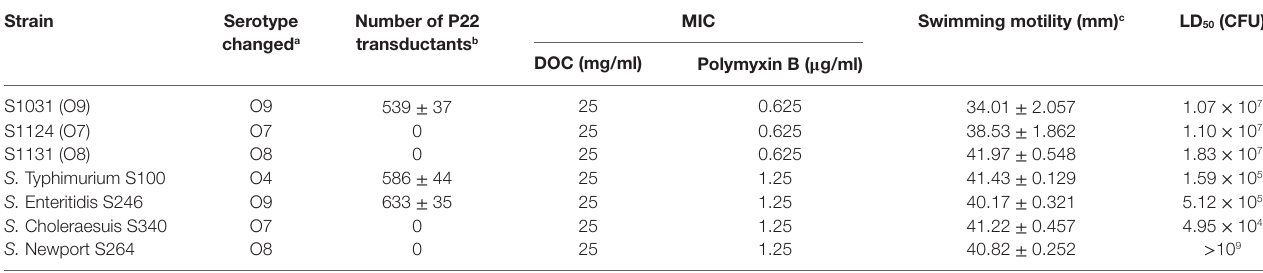
TaBle 2 | Transduction efficiencies, minimum inhibitory concentration (MIC) of deoxycholate (DOC) and Polymyxin B, swimming motility, and virulence of wild-type Salmonella and its derivatives. strain